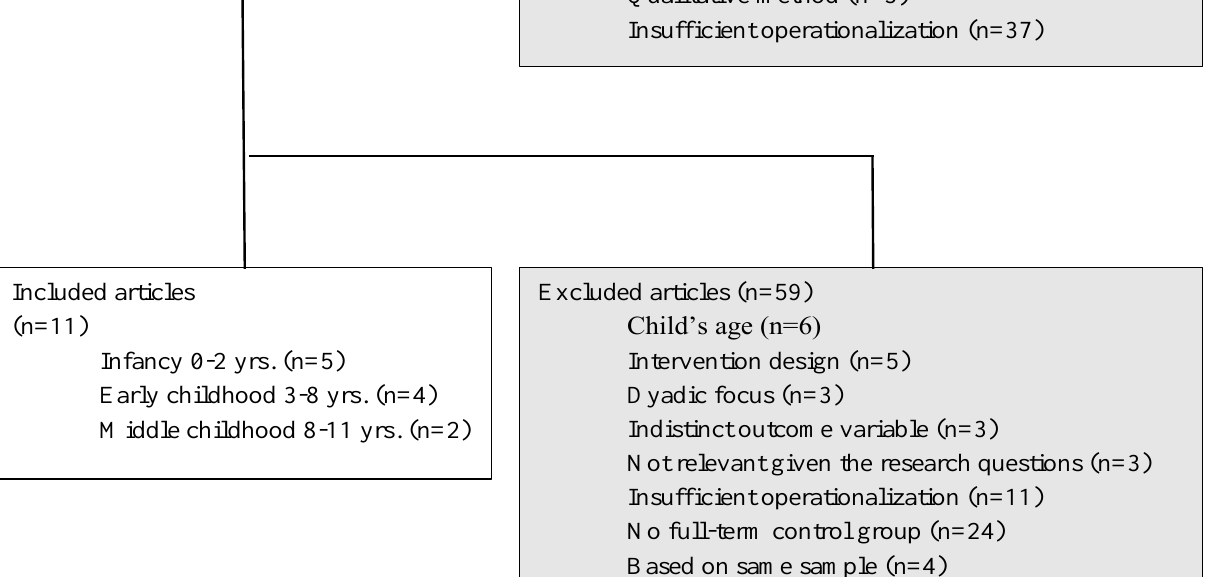
Figure 1. Summary of search procedures.